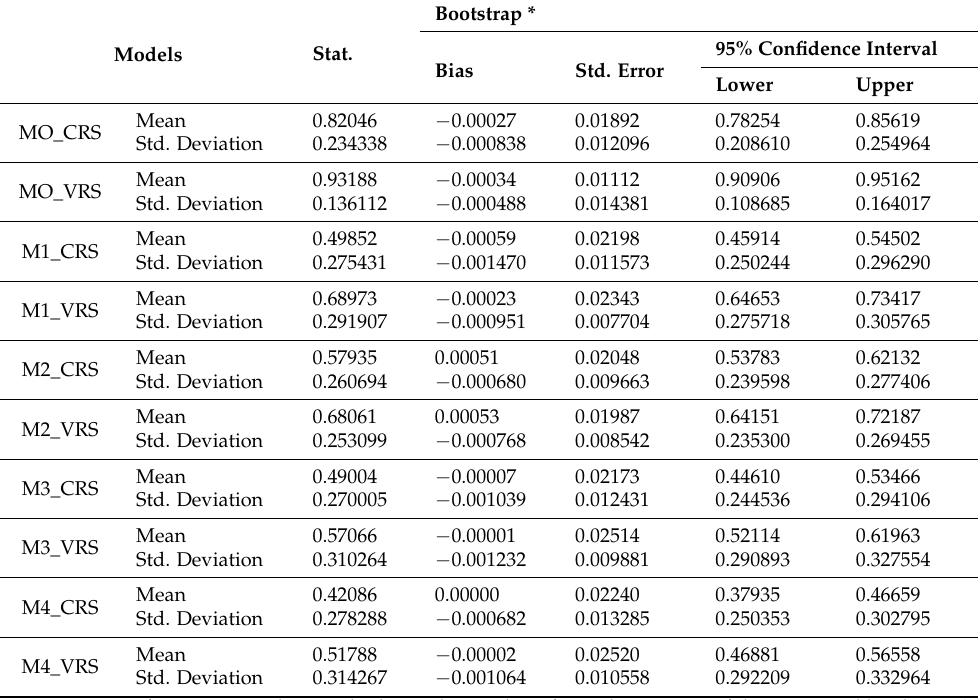
Table 6. Descriptive Statistics of the efficiencies calculated under the eight DEA analyses performed.